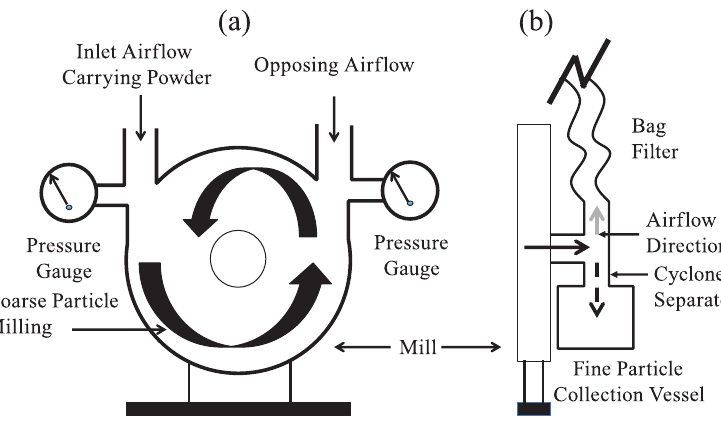
Fig. 1 Schematics of (a) front view of an air jet mill and (b) side view showing the filter and collection vessel separated by the cyclone behind the